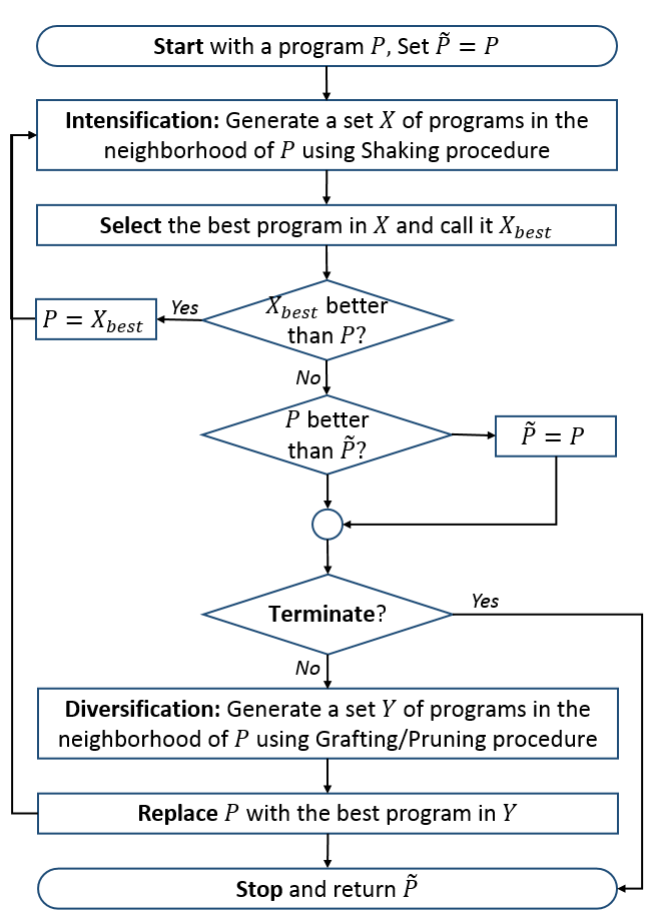
Figure 3. Flowchart of the LS